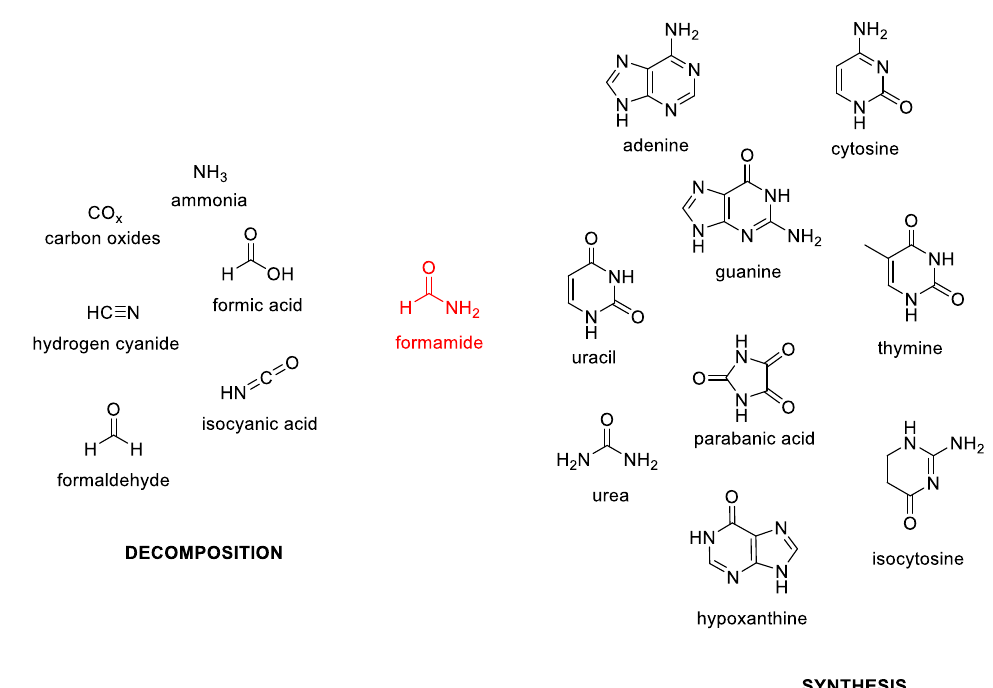
Figure 1. Main decomposition products and synthetic derivatives of formamide.